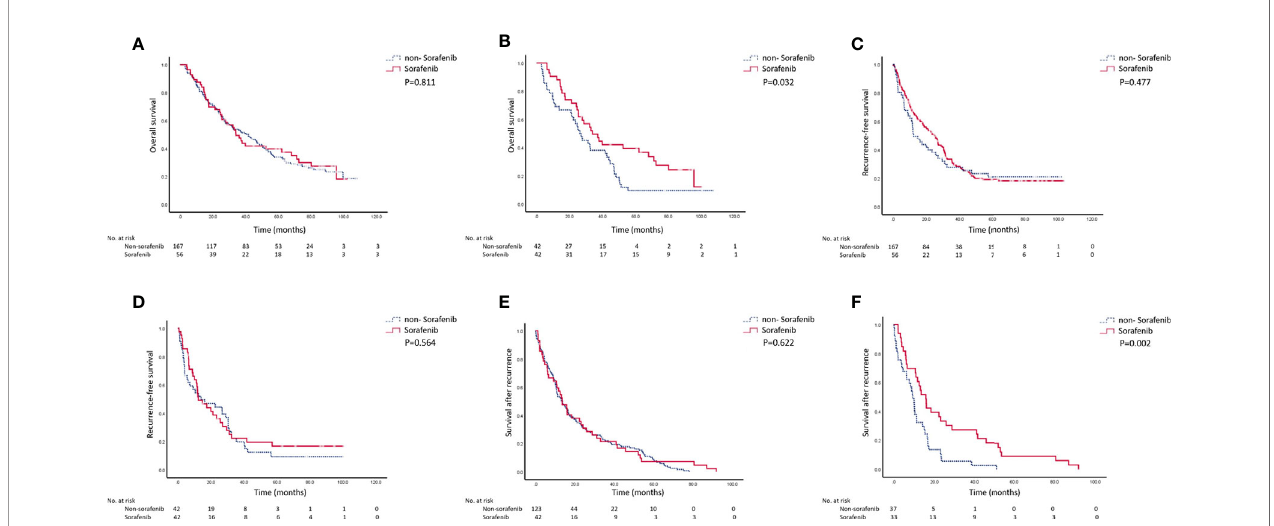
FIGURE 2 | Recurrence-free survival (RFS), overall survival (OS), and survival after recurrence before and after matching. (A) OS before matching (P = 0.811). (B) OS after matching (P = 0.032). (C) RFS before matching (P = 0.477). (D) RFS after matching (P = 0.564). (E) Survival after recurrence before matching (P = 0.622). (F) Survival after recurrence after matching (P = 0.002).